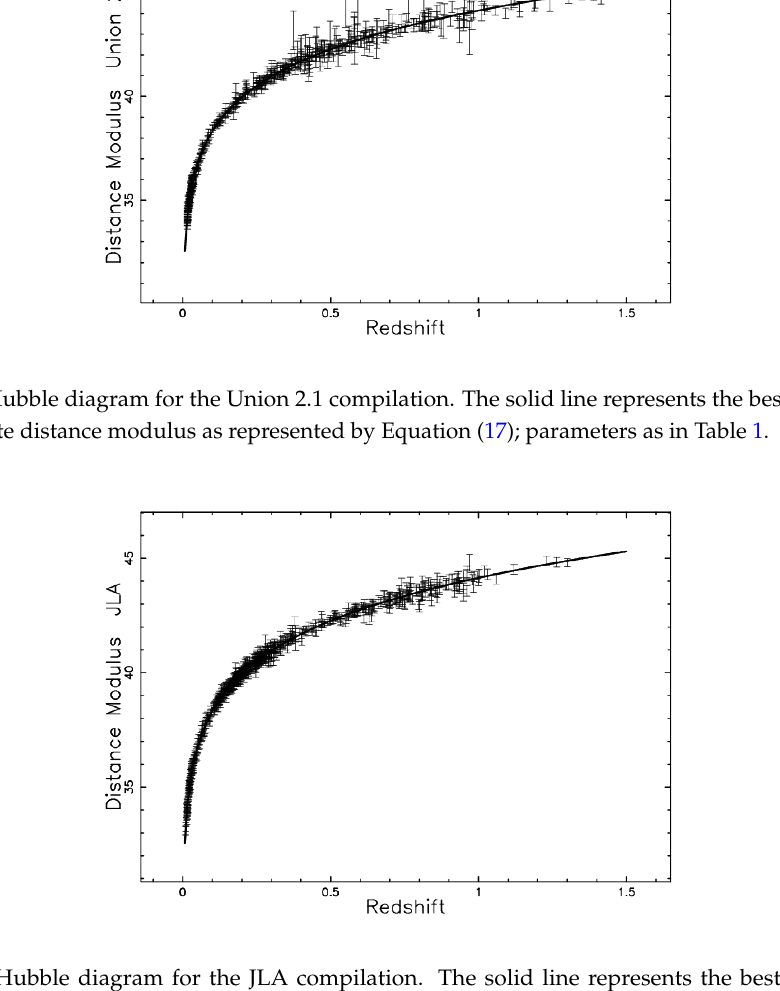
Figure 6. Hubble diagram for the JLA compilation. The solid line represents the best fit for the approximate distance modulus as given by Equation (17); parameters as in Table 1.